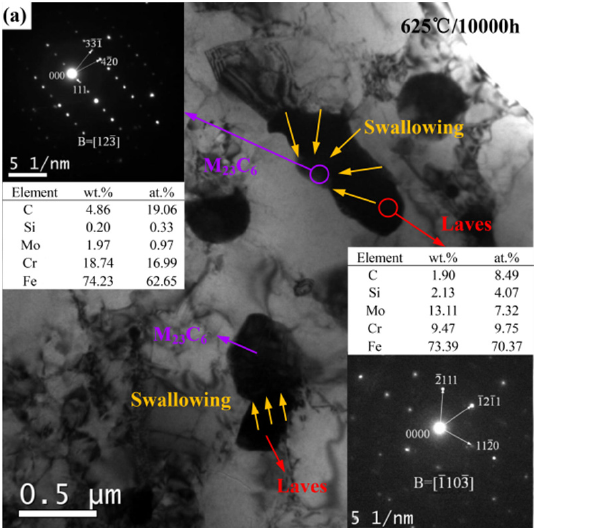
Figure 3. The growth mechanism for Laves phase aged at 625 °C for 10,000 h: ( a ) TEM BF image including SAED patterns and chemical composition of particles, ( b ) TEM image, the swallowing process has completed.